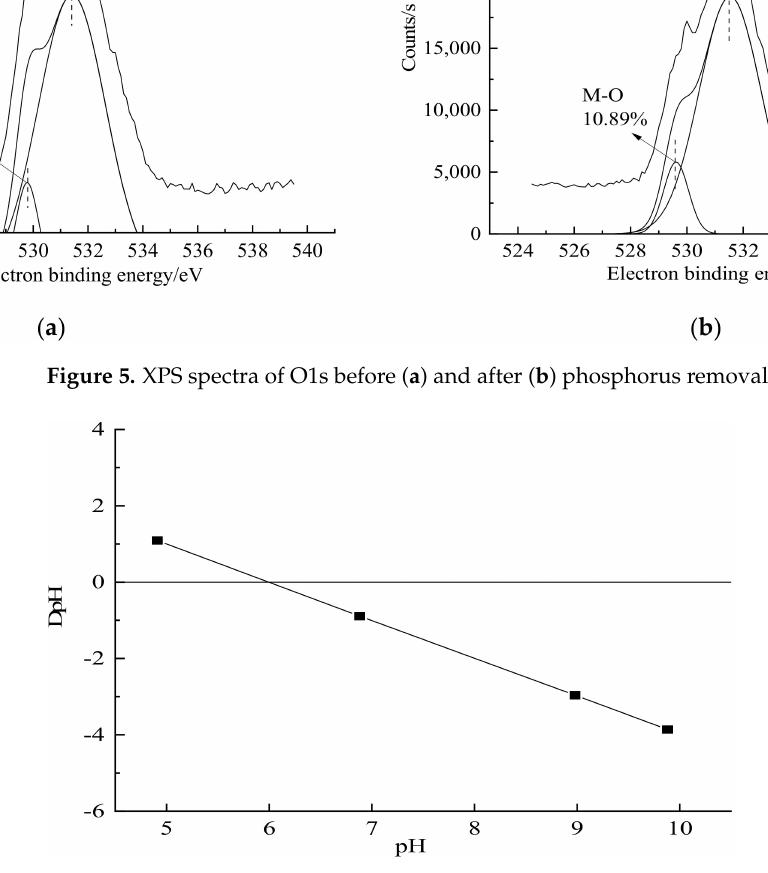
Figure 6. Test chart of surface zero-potential